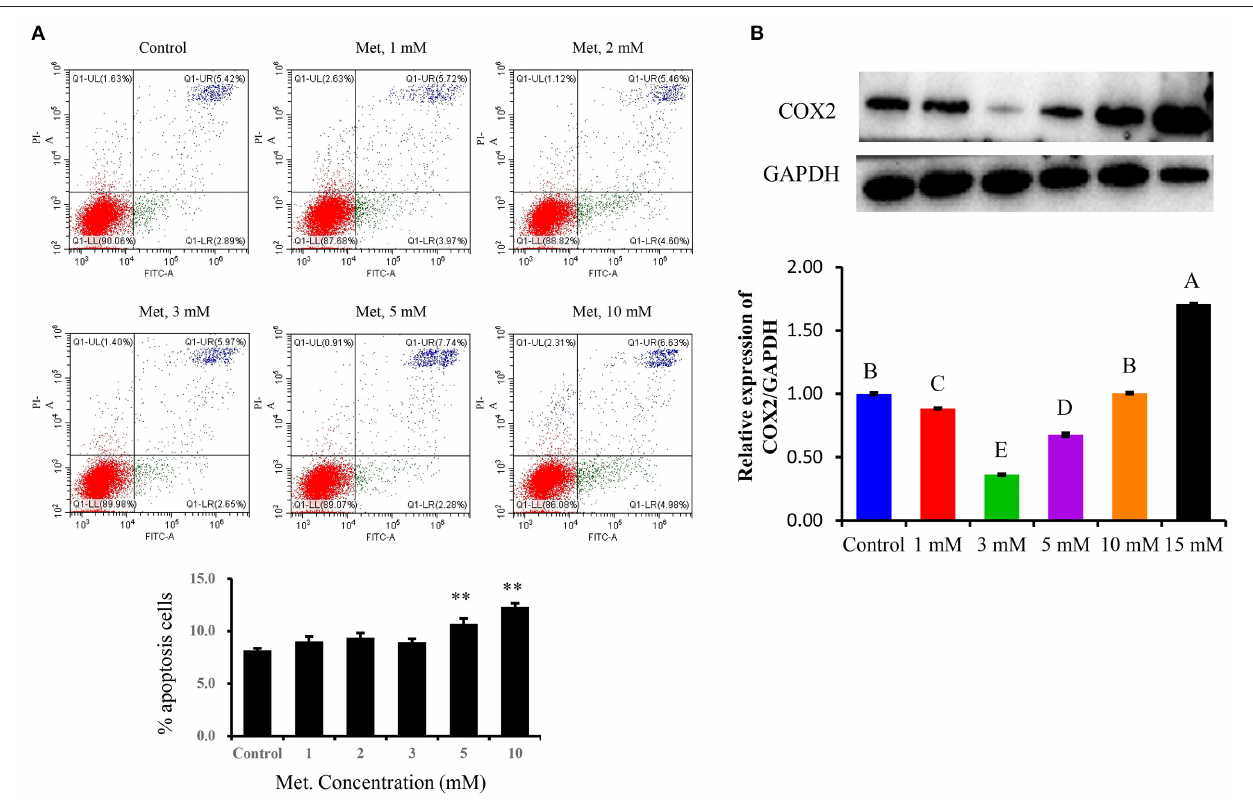
FIGURE 1 | Determination of the optimal metformin concentration in the study. Metformin was used to investigate its effect on growth and apoptosis in PBMECs. PBMECs were pretreated with the indicated concentrations of metformin (1, 2, 3, 5, and 10mM) and incubated for 12h; apoptotic cells were measured using flow cytometry, a statistical graph of the apoptotic death rates is shown in (A) . Western blot analysis was used to determine the optimum concentration of metformin among (1, 3, 5, 10, and 15mM) metformin doses (B) . Values represent means ± SEM, different uppercase letters (A–E) on the top of bars indicate significant differences ( n = 3, p < 0.05). **indicates p < 0.01 vs the Control